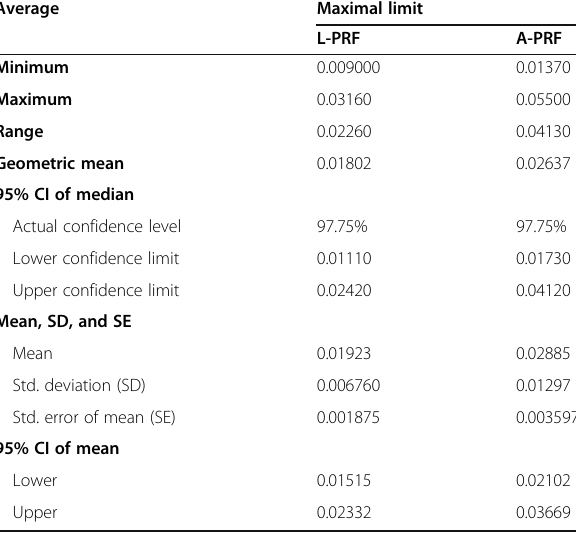
Table 2 Descriptive statistics of the traction data